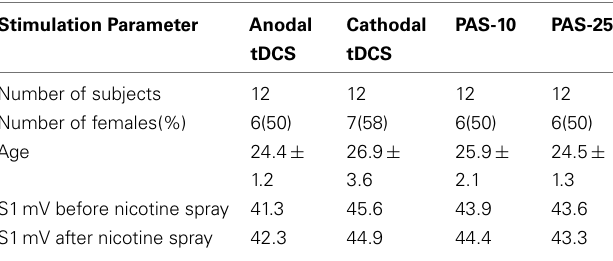
Table 1 | Characteristics of the subjects participating in the